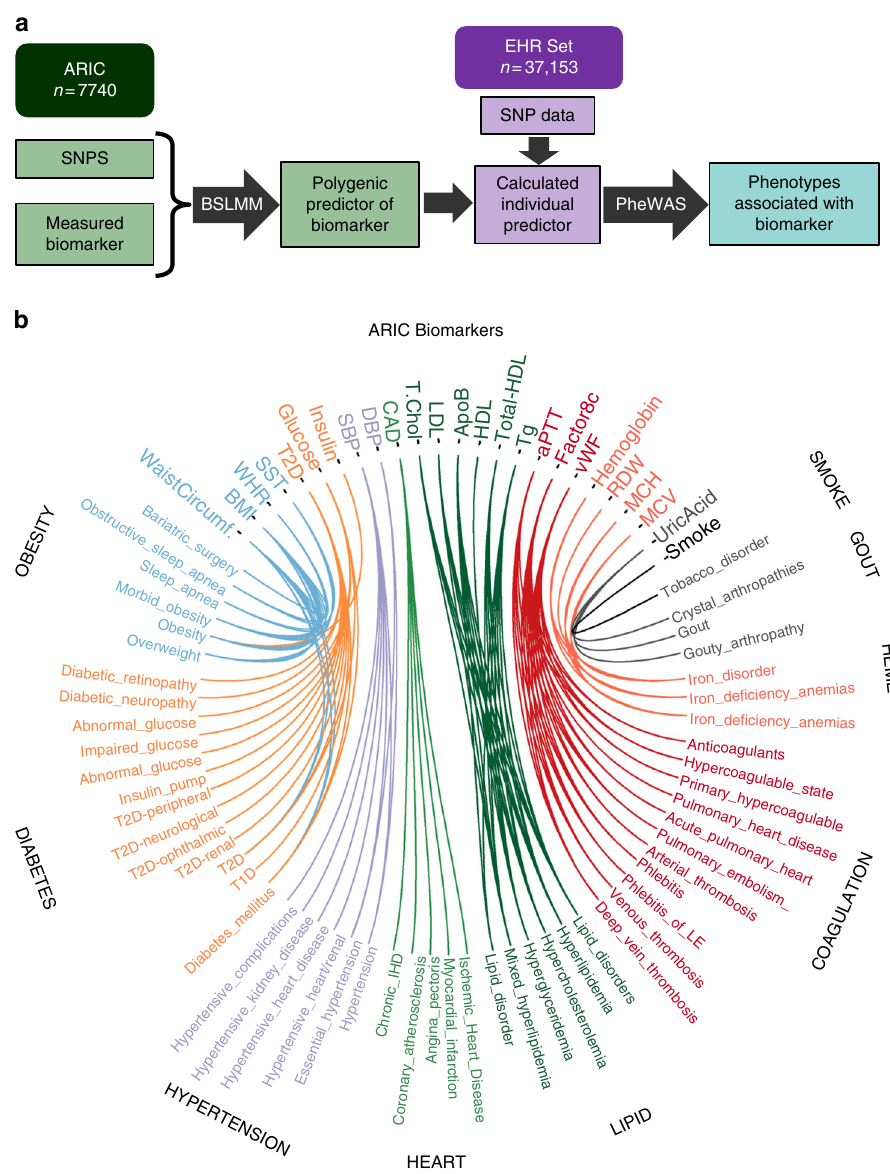
Fig. 1 Overview. a Overview of the study design. Bayesian sparse linear mixed modelling (BSLMM) was used to compute SNP weights for 53 biomarkers from the ARIC study. These weights were used to compute genetically predicted biomarkers in the EHR data set and phenome wide scanning (PheWAS) was used to identify clinical phenotypes associated with the genetically predicted biomarker. b Circos plot showing the 116 signi fi cant associations (Bonferroni p < 0.05) between the genetic predictors of the ARIC biomarkers and pheWAS phenotypes. Associations are denoted by lines. Coloring is used to highlight similar groups of biomarkers and pheWAS